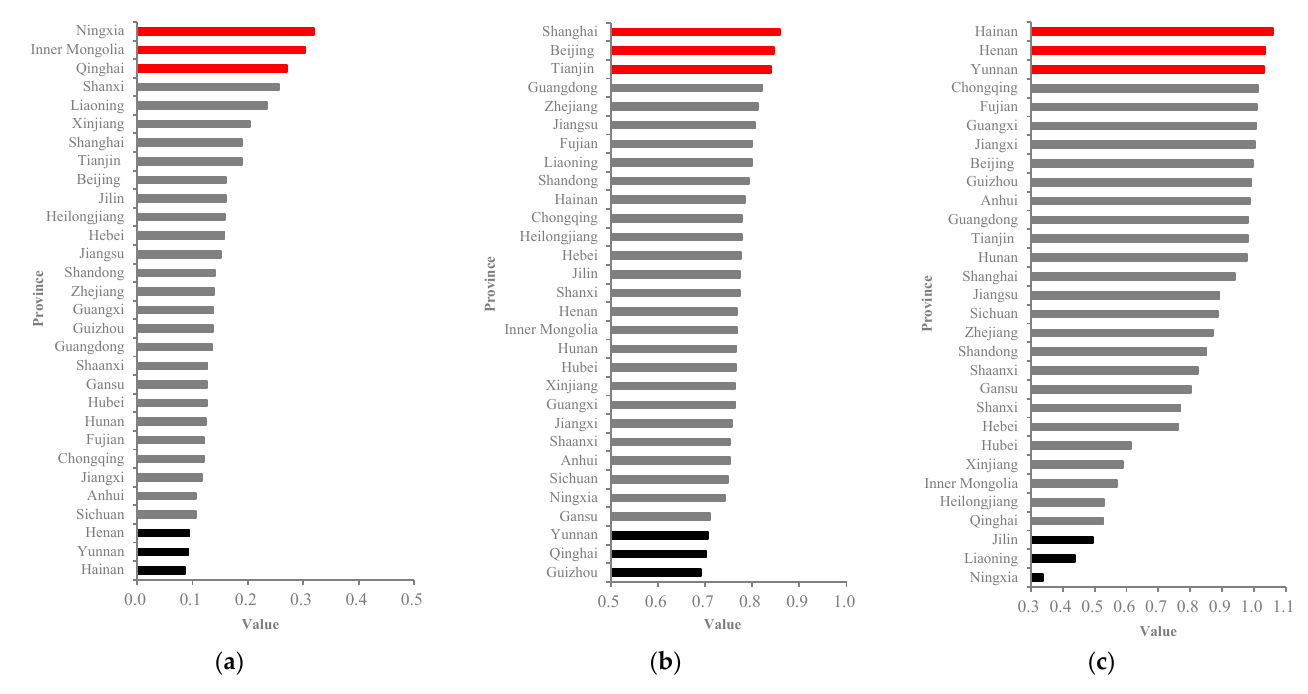
Figure 5. ( a ). The average provincial value of the ECI among 30 provinces from 1997 to 2019 in China. ( b ) The average provincial value of the HDI among 30 provinces from 1997 to 2019 in China. ( c ) The average provincial value of the EWP efficiency among 30 provinces from 1997 to 2019 in China.